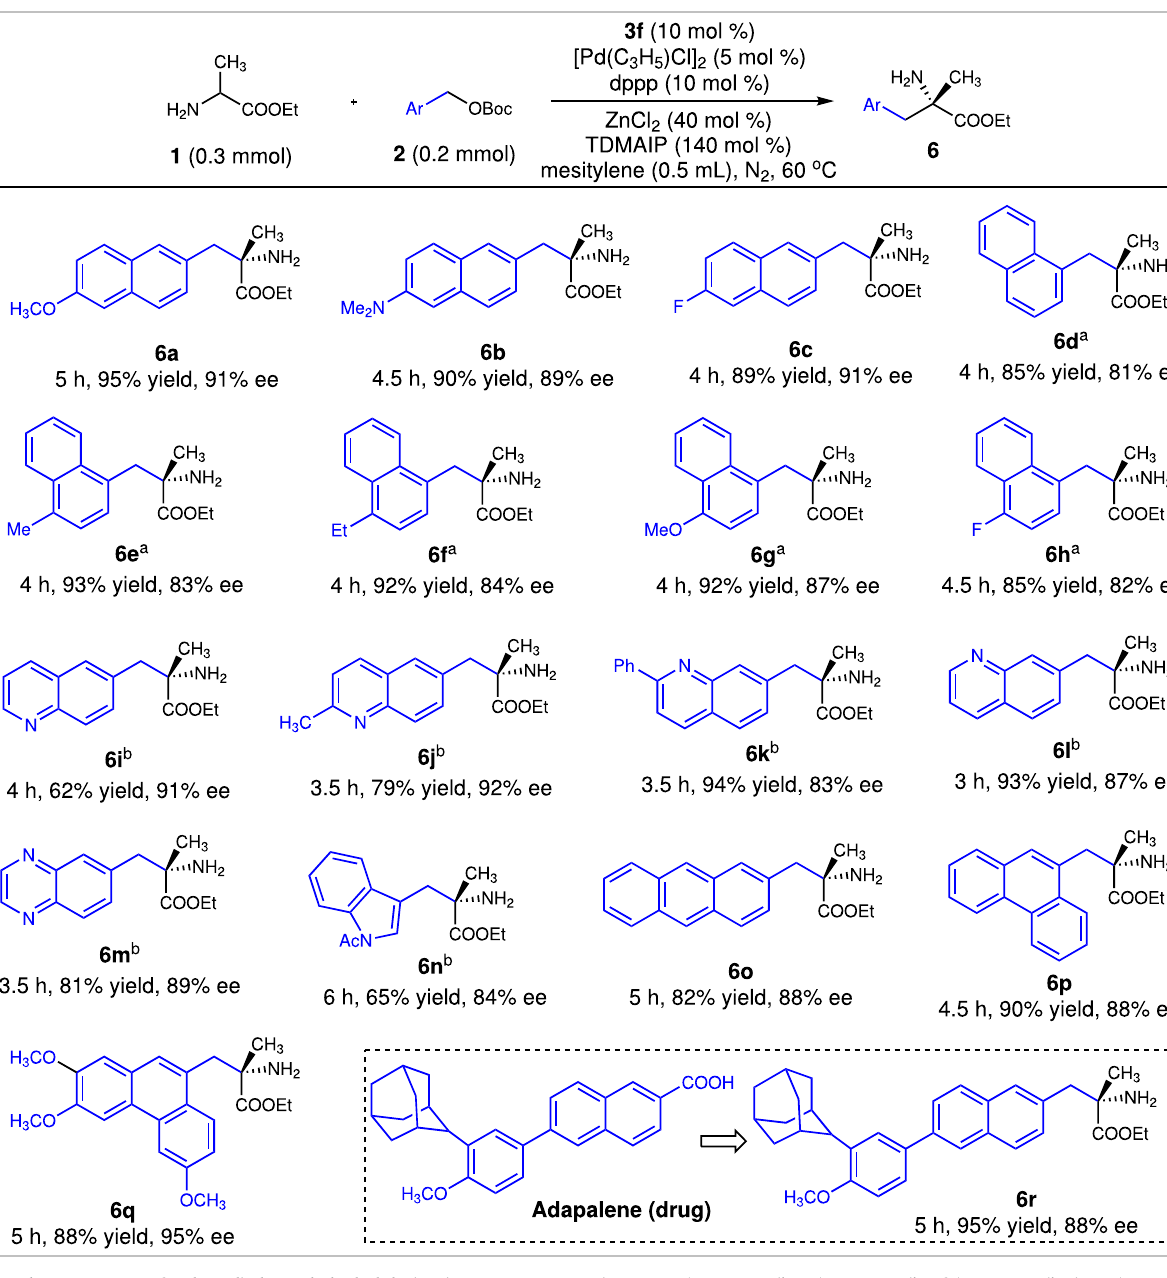
Fig. 3 Substrate scope of polycyclic benzyl alcohol derivatives. Reaction conditions: 1a (0.30 mmol), 2 (0.20 mmol), 3f (0.02 mmol), dppp (0.02 mmol), [Pd(C 3 H 5 )Cl] 2 (0.01 mmol), tris(dimethylamino)iminophosphorane (TDMAIP, 0.20 mmol), and ZnCl 2 (0.08 mmol) were stired in mesitylene (0.5 mL) at 60 °C under the nitrogen atmosphere for indicated time. Isolated yields. The enantioselective excess (ee) was determined by HPLC. a At 80 °C. b Yields and ees were given by the N - Boc-protected